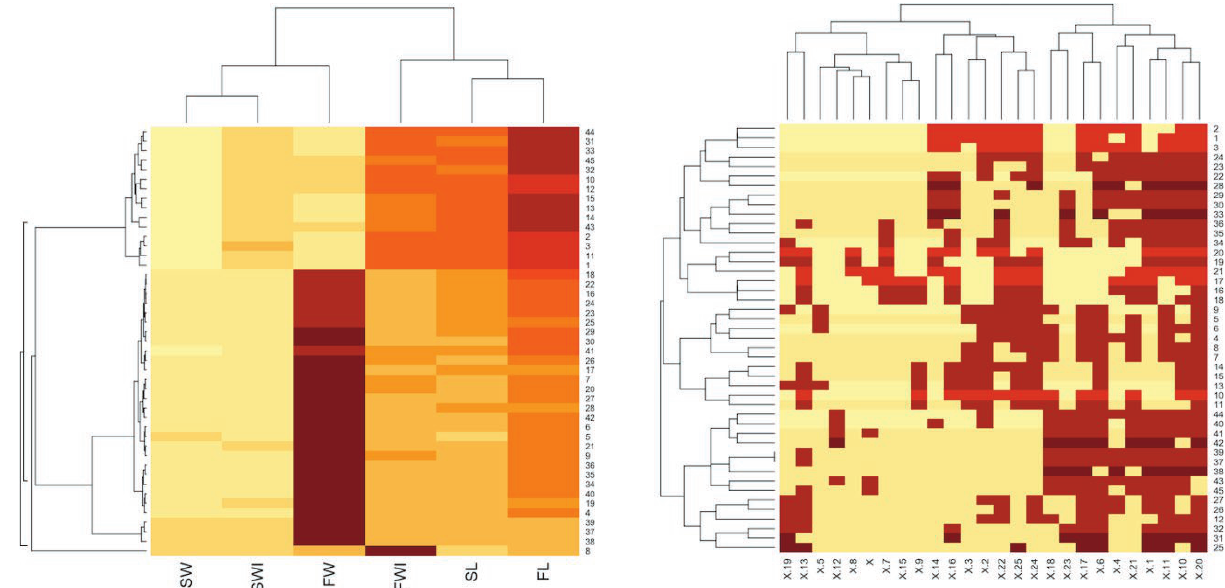
Figure 8. Heat maps of 45 date palm cultivars based on morphological and genetic (SSRs) data, showing different groupings of these culti- vars. (Abbreviations in morphological heat map are: SW = Seed weight, SWI = Seed width, FW = Fruit weigh, SL = Seed. length, and. FL = Fruit